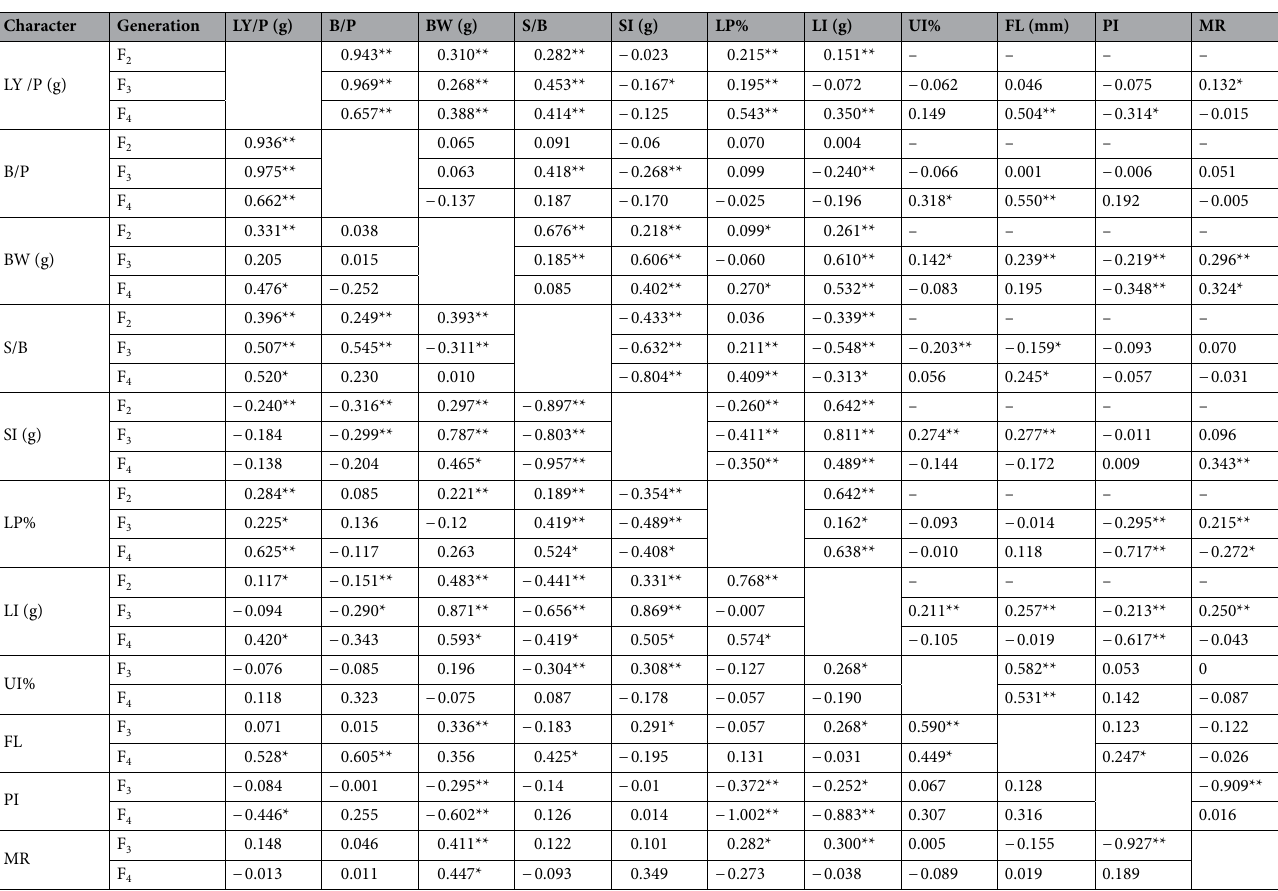
Table 2. Phenotypic(r p ) (above diagonal) and Genotypic(r g ) (below diagonal) correlation coefficients in F 2 , F 3, and F 4 generations between all pairs of studied traits. * and ** mean significant at 0.05 and 0.01 levels of probability,